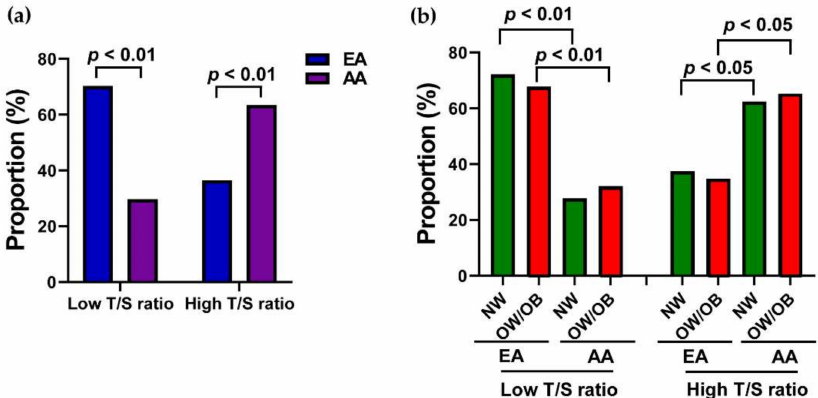
Figure 2. Proportion of participants with low and high T/S ratio groups. ( a ) The proportion difference participants with low and high T/S ratios in EA and AA children. ( b ) The proportion difference among NW and OW/OB children of EA and AA participants with low and high T/S ratios.